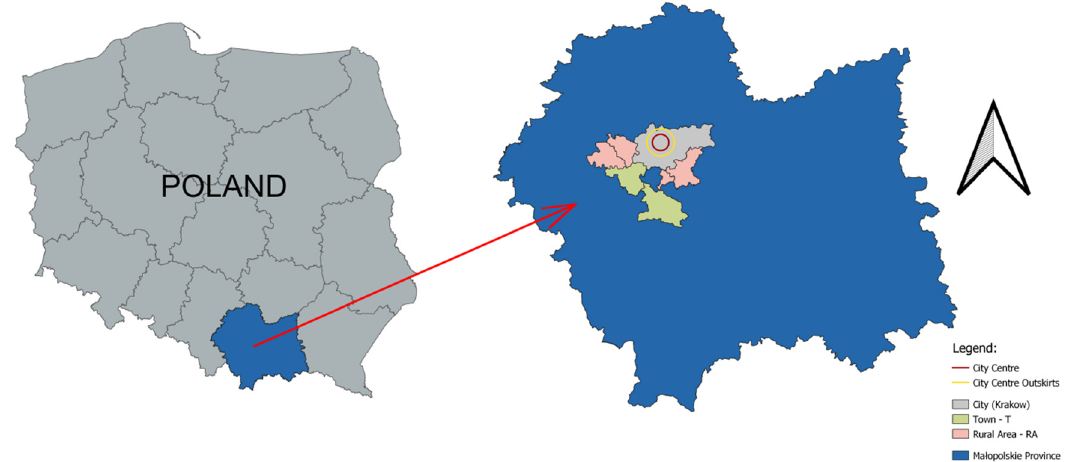
Figure 6: Selected locations in Ma ł opolskie